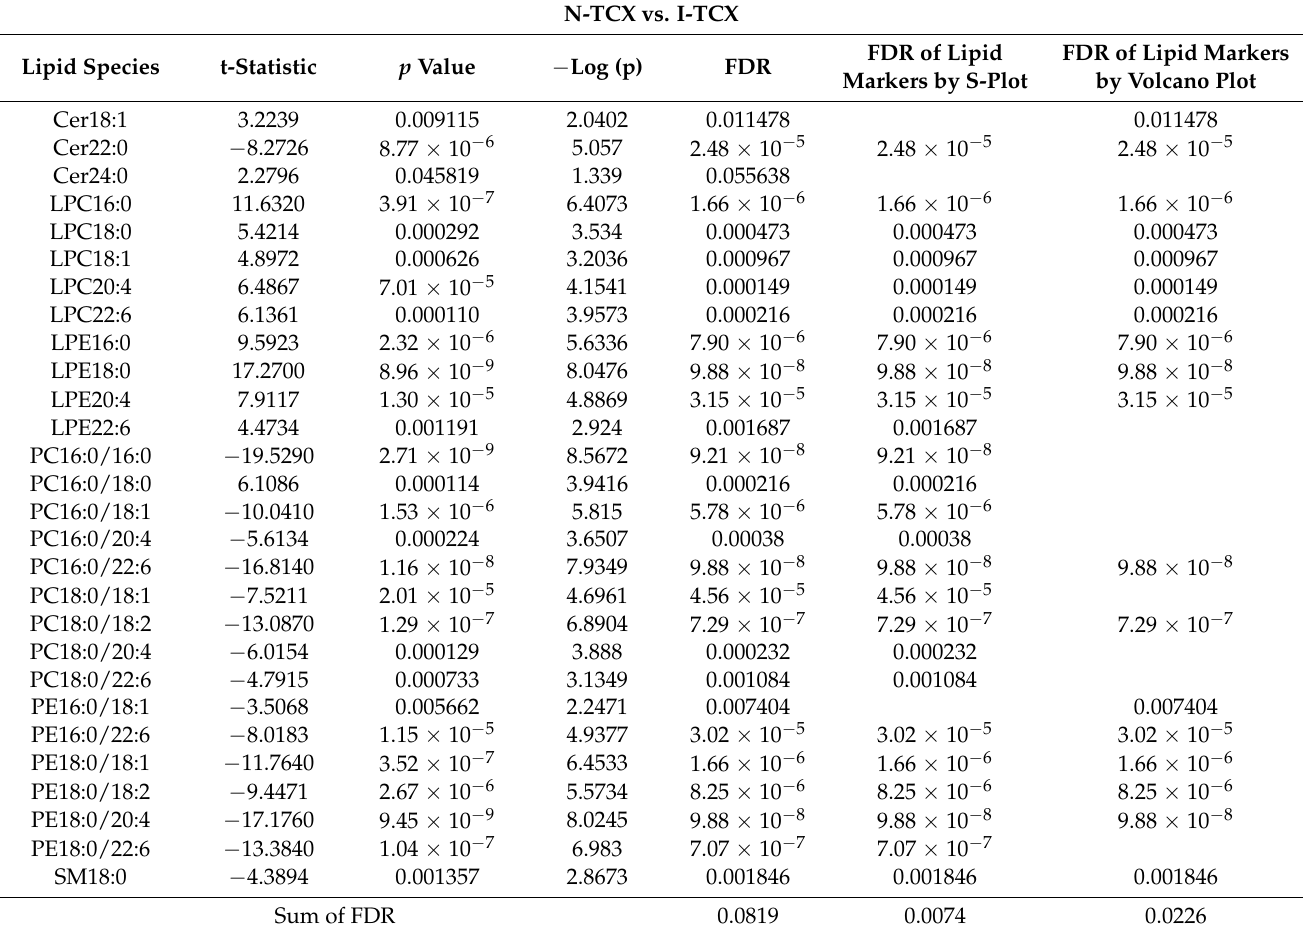
Table 3. List of lipid species showing statistical significance ( p < 0.05) between I-TCX and N-TCX (N = 6 each, unpaired t -test), with their respective t-statistic, p value, − log(p), false discovery rate (FDR) of each listed lipid species, and the sum of FDR from all listed lipid species, (the FDR column), from the S-plot of OPLS-DA-identified markers, and from the volcano-plot-identified markers. N-TCX vs.